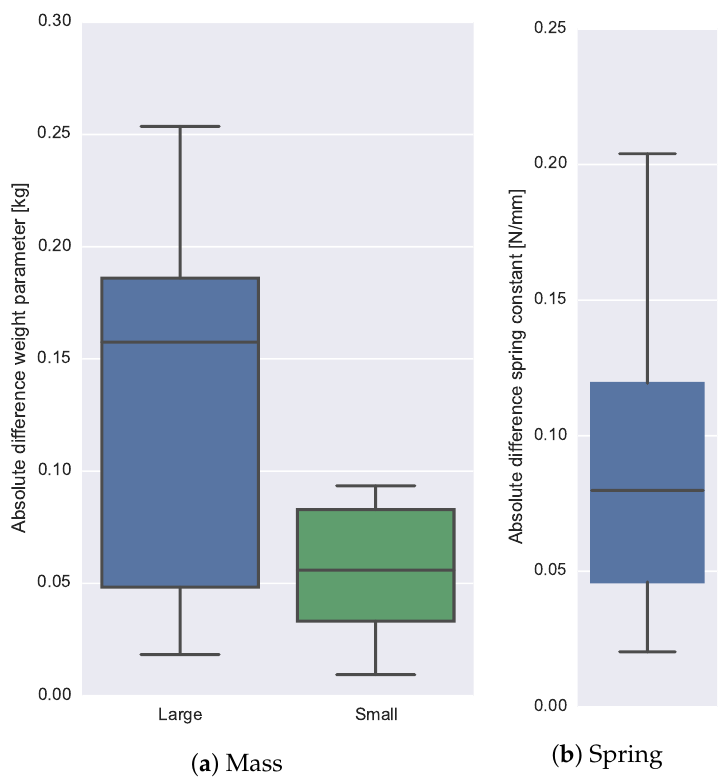
Figure 9. Boxplots of the absolute difference measures of the mass parameter (kg) estimated during Experiment 1 where two different loads were manipulated ( a ). A boxplot of the stiffness parameter (N/mm) estimated during Experiment 2 ( b ) . The median, upper and lower quartiles and outliers (dots) are visualized. All experiments were conducted 10